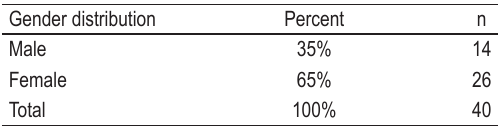
TABLE 1. Gender distribution in the sample of 40 individuals